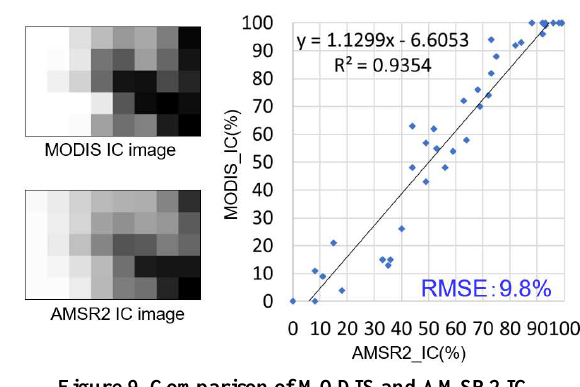
Figure 9. Comparison of MODIS and AMSR2 IC (Sea of Okhotsk, February 24, 2015)